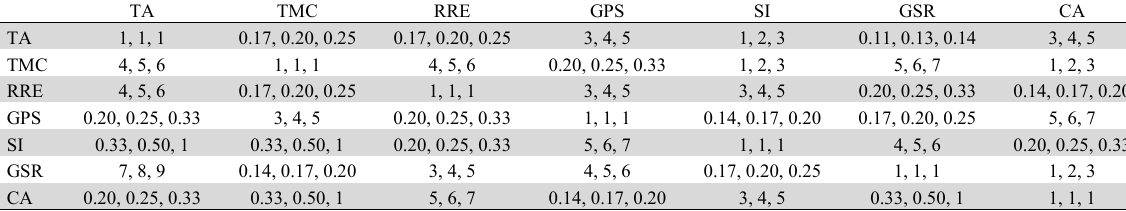
V Values for enablers of GSCM